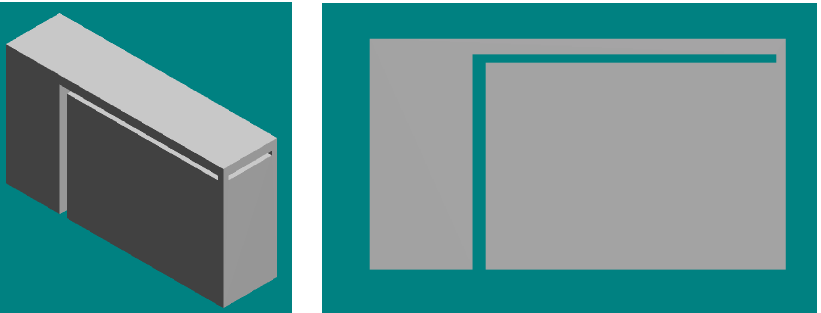
Figure 14. CAD model of a long overhang with heat support plus anchors.